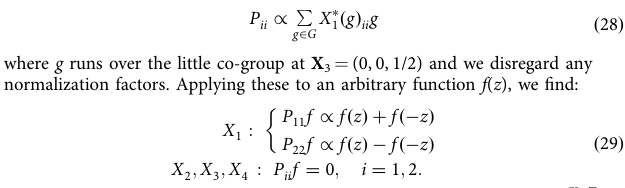
Fig. 7 Effect of the X 1 modulation and Weyl points coupling. From the analytical model, a four-fold degeneracy point is achieved at the folding condition B z ¼ δ α , as shown in panel a . When a X 1 modulation is (cid:3) β introduced, the Weyl dipole couples and a band-gap is opened, as showed in panel b . Parameters: a = − 7, b = − 30, α = 1, c = 1, d = 30, γ = 1, β